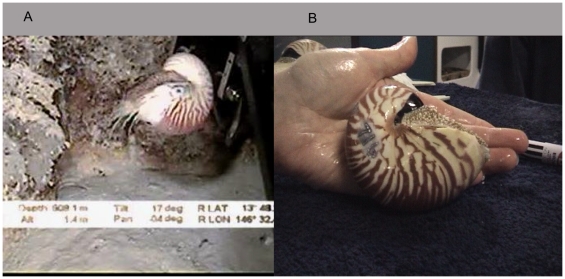
Juvenile Nautilus pompilius.A: Juvenile N. pompilius about 70 mm shell length filmedfrom the ROV actively foraging at 608.1 m at North Horn, Osprey Reef. B: Nautilus # 716 with shell length of 89.5 mm captured by trap from 330 m. Note the cessation of color banding lines at the apertural margin and the start of this area becoming a fully white region, indicative of final juvenile stage.